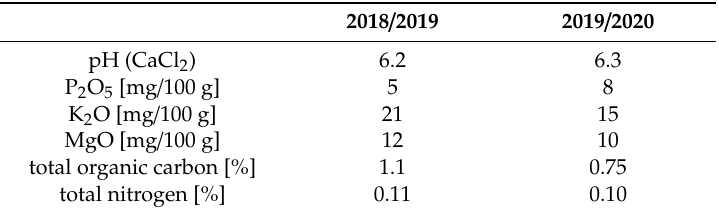
Table 1. Soil parameters of the experimental fields in the topsoil (0–30 cm depth) in 2018 / 2019